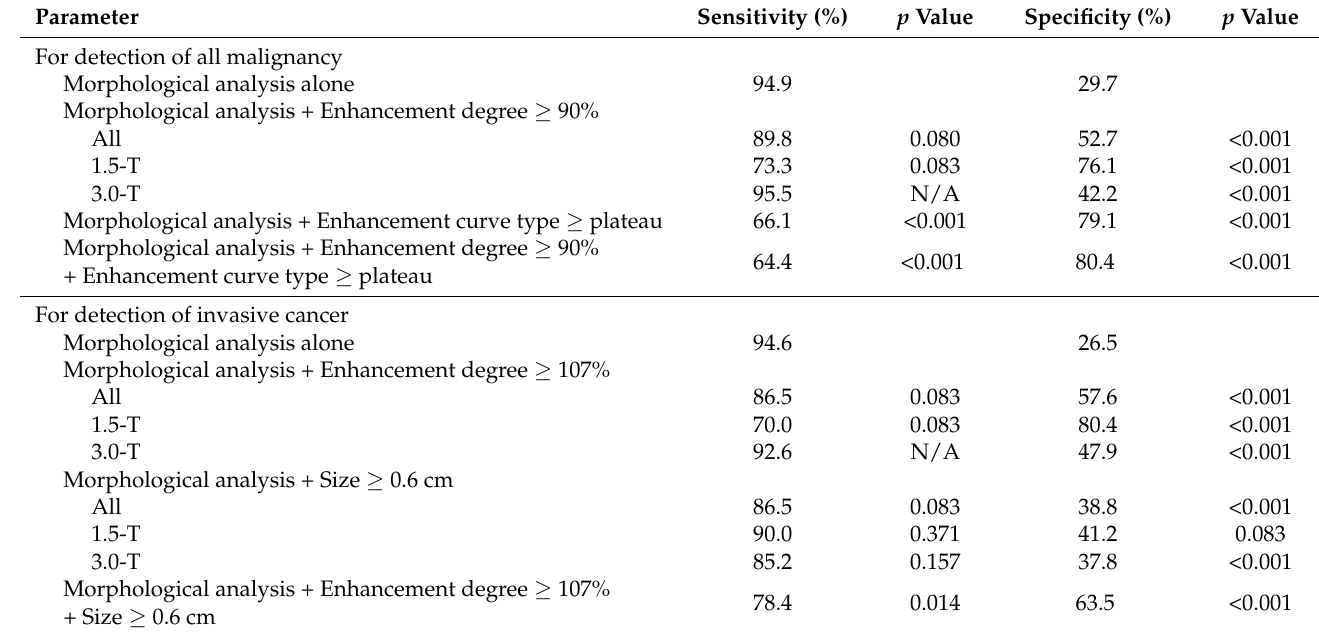
Diagnostic performance of parameters for differentiating benign and malignant breast